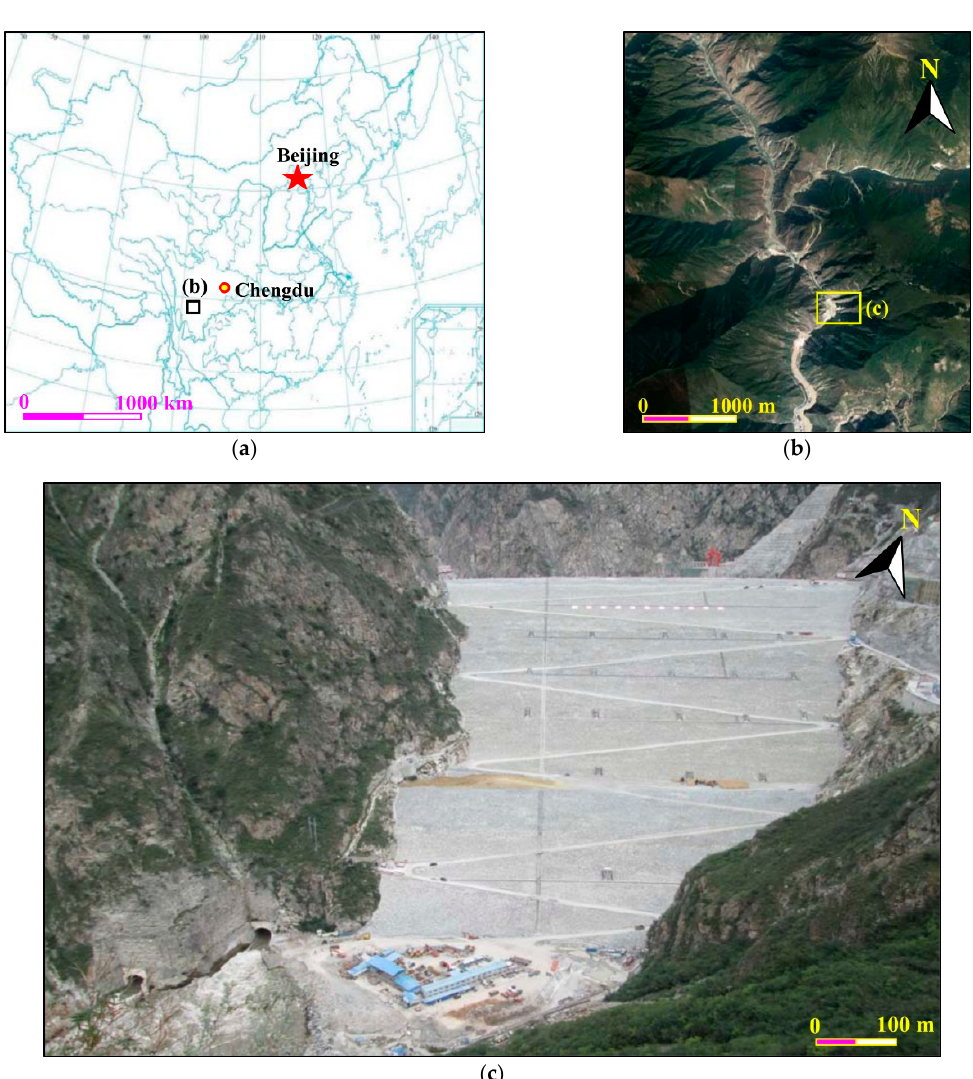
Figure 1. Location and layout of the dam at Changheba Hydropower Station: ( a ) and ( b ) location of the Changheba Hydropower Station, ( c ) layout of the dam at Changheba Hydropower Station.